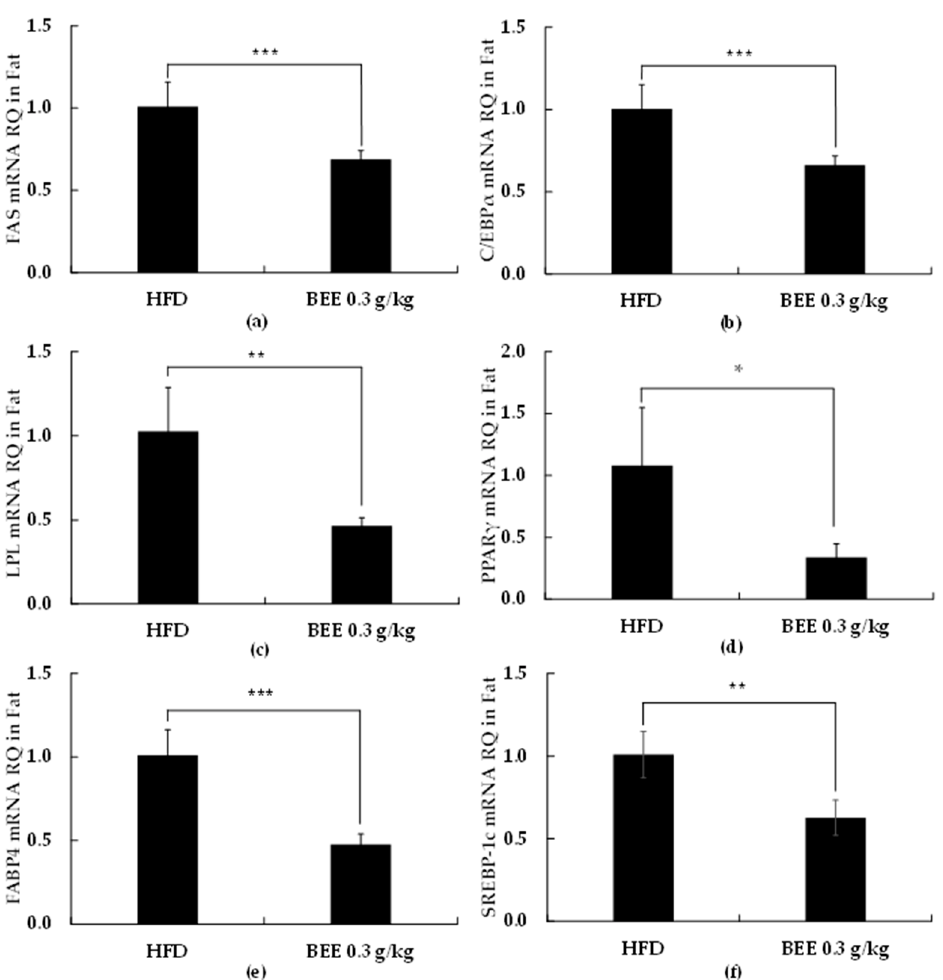
Figure 4. RT, real-time PCR quantitative analysis of adipocyte differentiation-related genes expres- sion in the 3T3-L1. For real-time PCR, we used SYBR green mix with gene-specific primers (( a ): fatty acid synthase (FAS), ( b ): CEBP/ α , ( c ): lipoprotein lipase (LPL), ( d ): PPAR γ , ( e ): FABP4, and ( f ): SREBP-1c). Each value is expressed as mean ± S.D. and is representative of at least three separate experiments. Different letters indicate statistically significant differences between groups with one- way ANOVA followed by Duncan’s test of p < 0.05. The results are expressed as the mean ± S.D ( n ≥ 6). Statistical significances from control group were determined by Student’s t -test (* p < 0.05, ** p < 0.01, *** p < 0.001).